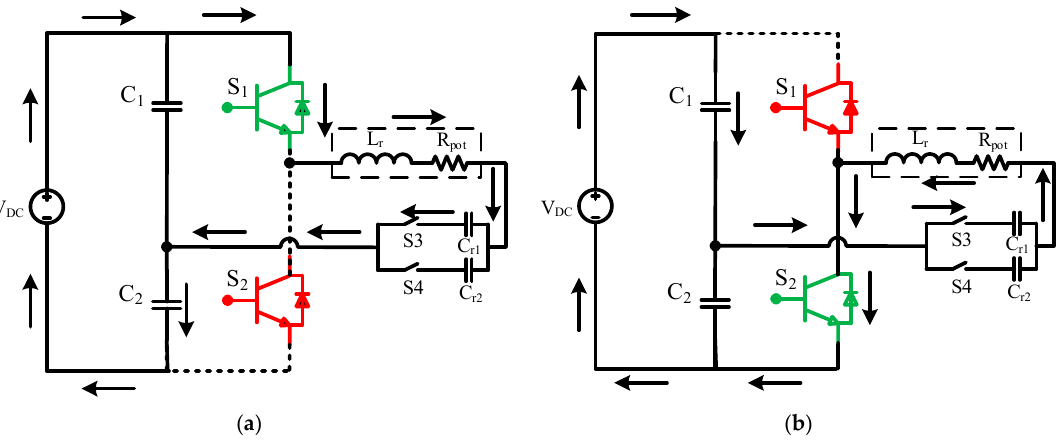
Figure 5. Circuit diagrams for ferrous heating mode: ( a ) S1 in ON state; ( b ) S2 in ON state.